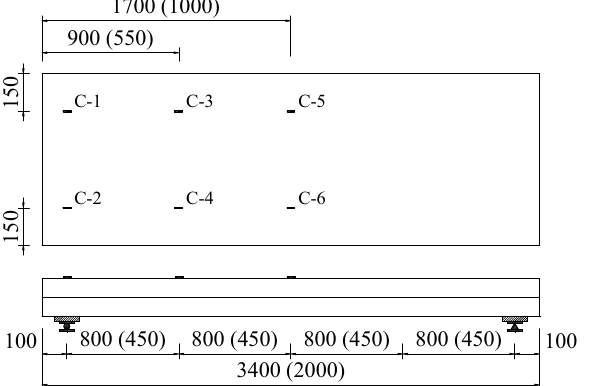
Figure 7. Location of strain gauges on the surface of concrete (all dimensions are in mm).